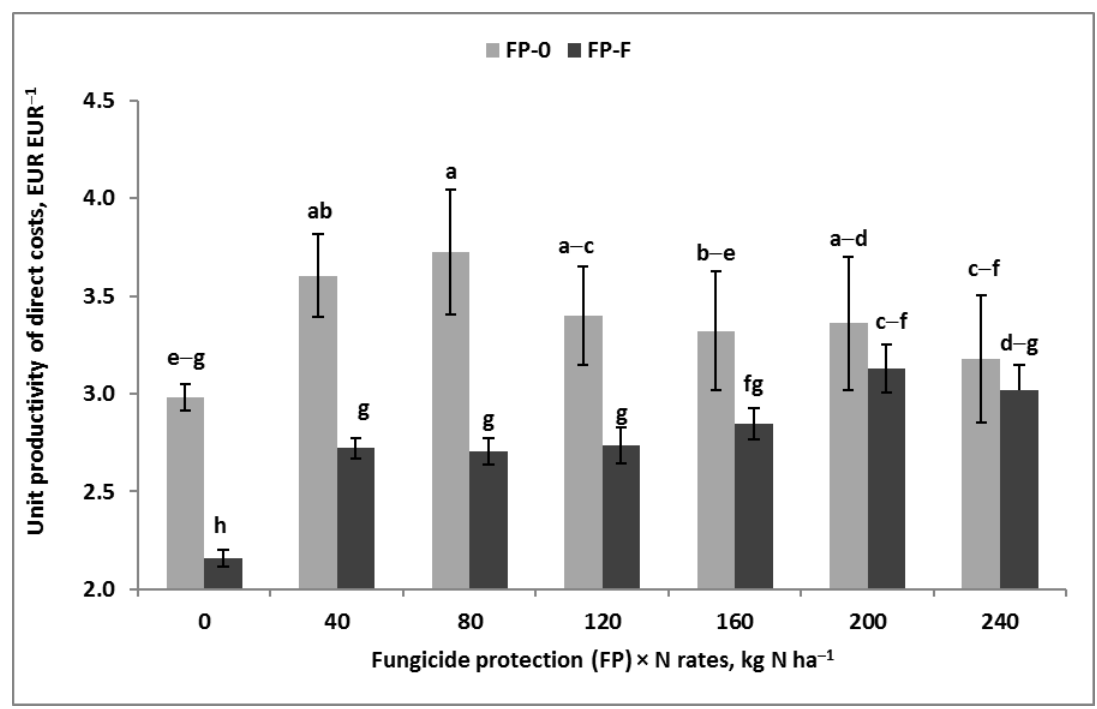
Figure A4. Regression models of net profitability response to increasing rates of fertiliser nitrogen on the background of winter wheat protection with fungicides.